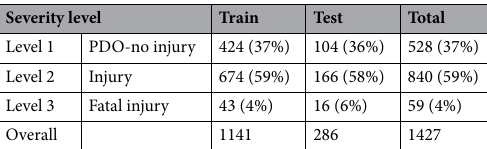
Table 1. Injury severity categories in the crash